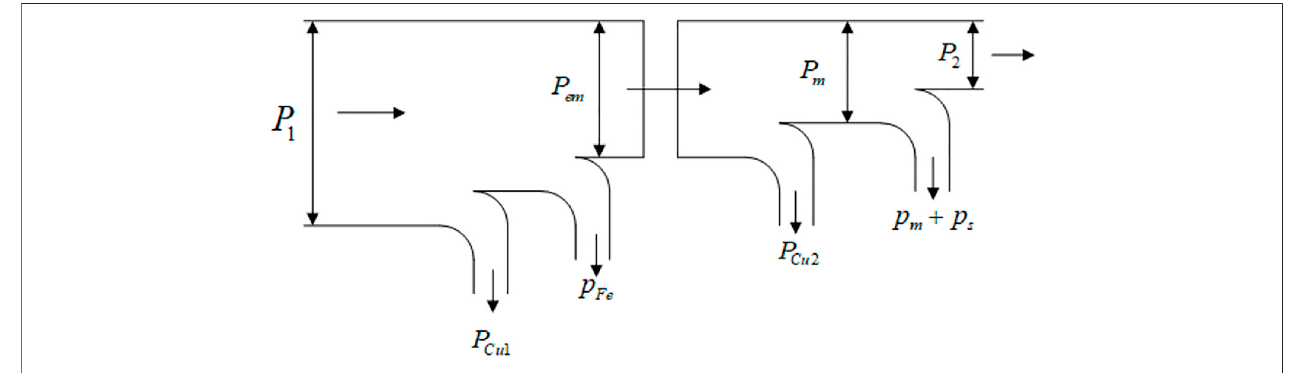
FIGURE 2 | Power fl ow of a three-phase asynchronous